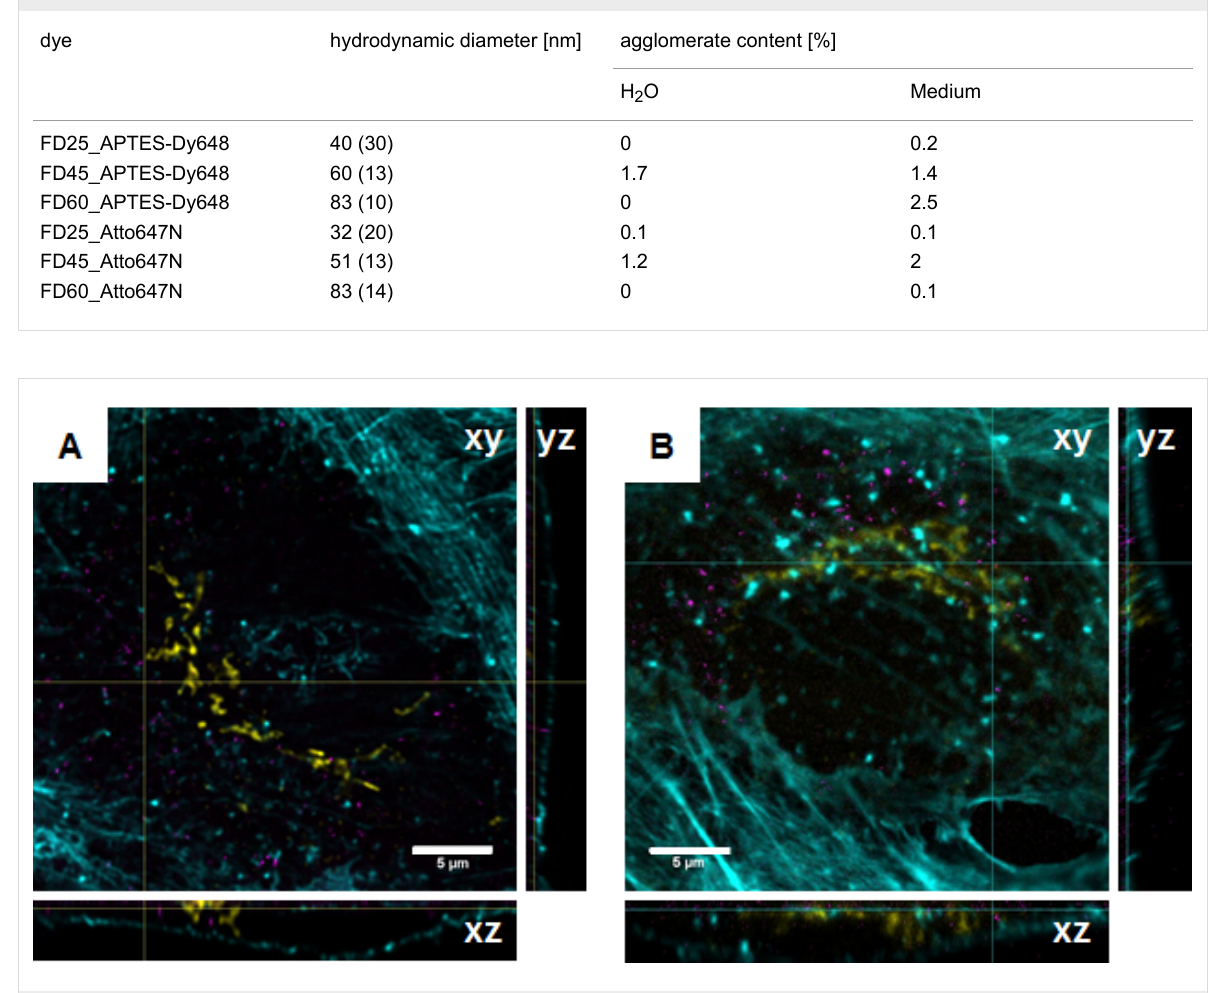
Figure 6: Confocal microscopic images of A549 cells exposed to 10 µg/mL FD25_Star635 (A) or FD25_Atto647N (B) for 24 h. Images represent the x – y , x – z and y – z sections derived from confocal z -stacks. The orthogonal projections indicate the intracellular location of the particles. The actin cytoskeleton is depicted in cyan, the cis-Golgi network in yellow and silica nanoparticles in magenta.